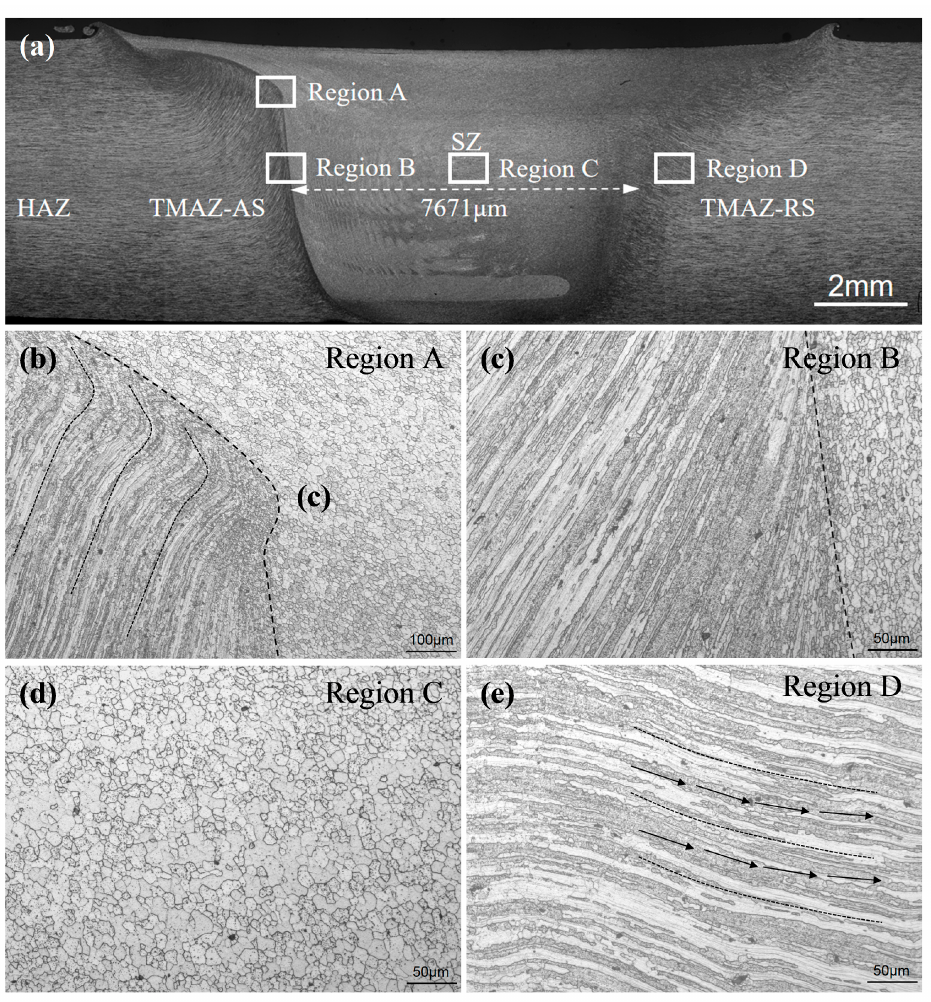
Figure 5. Macrostructure and microstructure of the FSW joint: ( a ) Macrostructure; ( b ) SZ / TMAZ junction; ( c ) TMAZ-AS; ( d ) SZ and ( e ) TMAZ-RS.